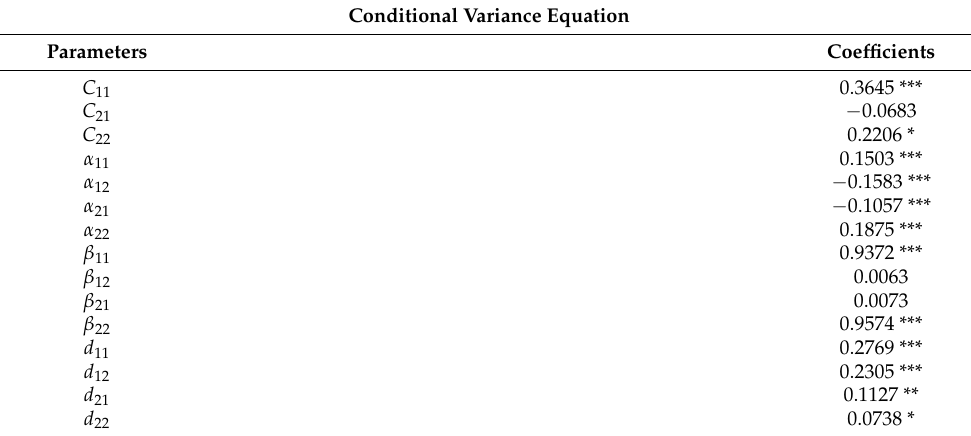
Table 3. Volatility spillover between the JSE ( r JSE ) and dollar-funded carry trade ( r CT/Dollar ) returns.